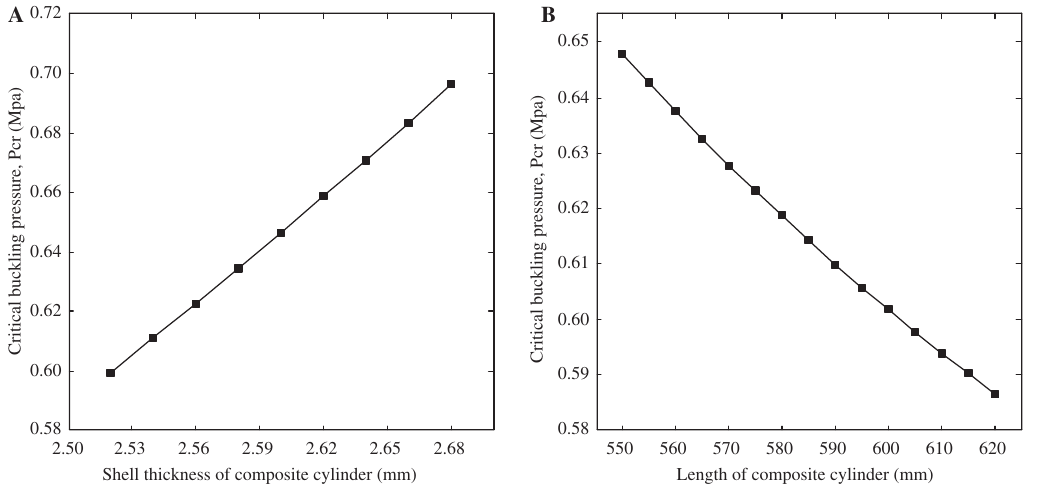
Figure 3: Critical buckling pressure vs. geometry parameter of the composite cylinder. (A) Shell thickness of the composite cylinder. (B) Length of the composite